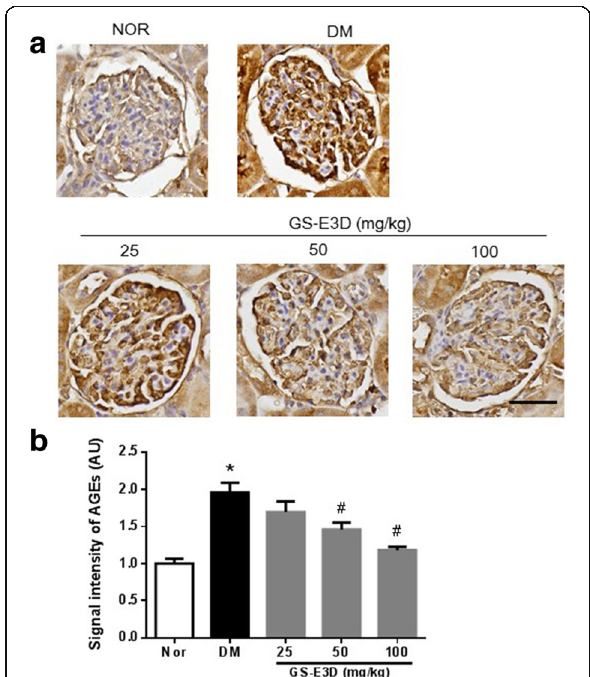
Fig. 3 The effect of GS-E3D on renal accumulation of advanced glycation end-products (AGEs). ( a ) Immunohistochemical staining for AGEs. Scale bar equals 50 μ m. ( b ) Quantification of the AGE signal intensity. NOR, normal rat; DM, streptozotocin-induced diabetic rat; GS-E3D, DM treated with the indicated dose of GS-E3D. All data were expressed as mean ± the standard error of the mean ( n = 8); * p < 0.05 vs. NOR group; # p < 0.05 vs. DM group